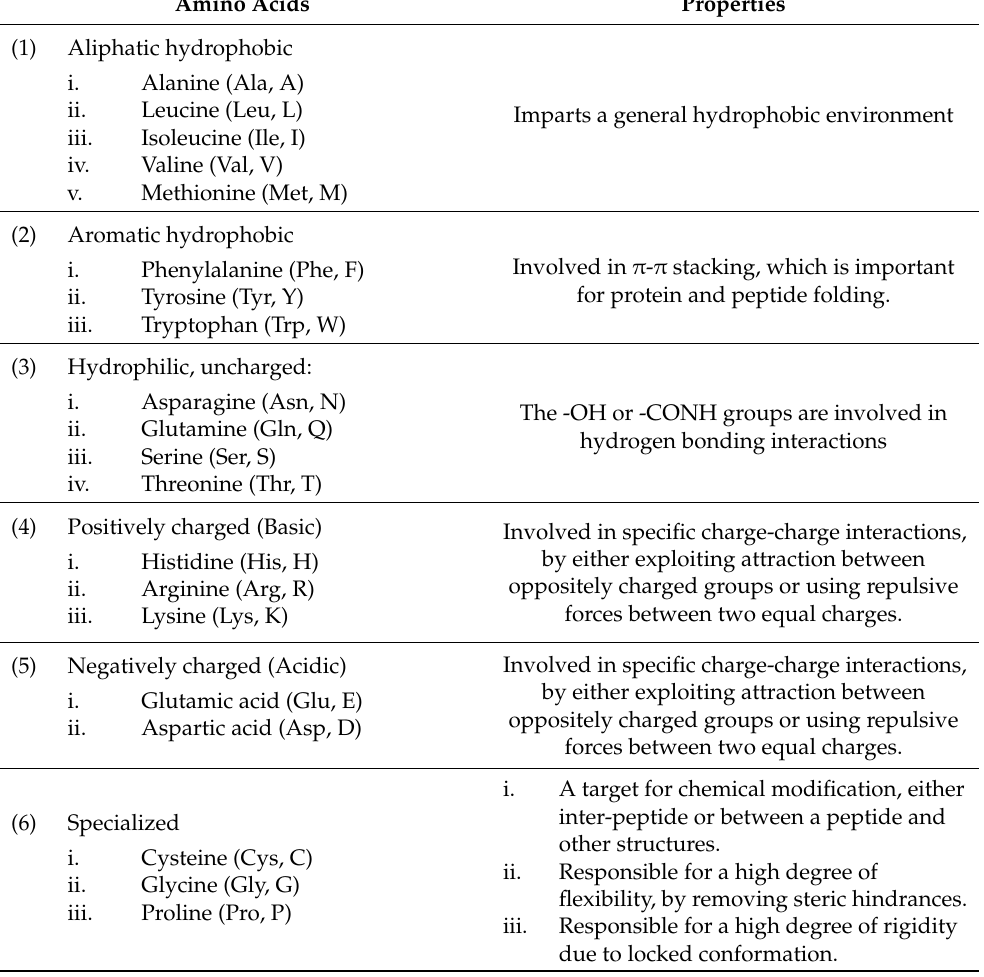
Table 1. The chemical properties of different types of amino acids [6,18]. Amino Acids